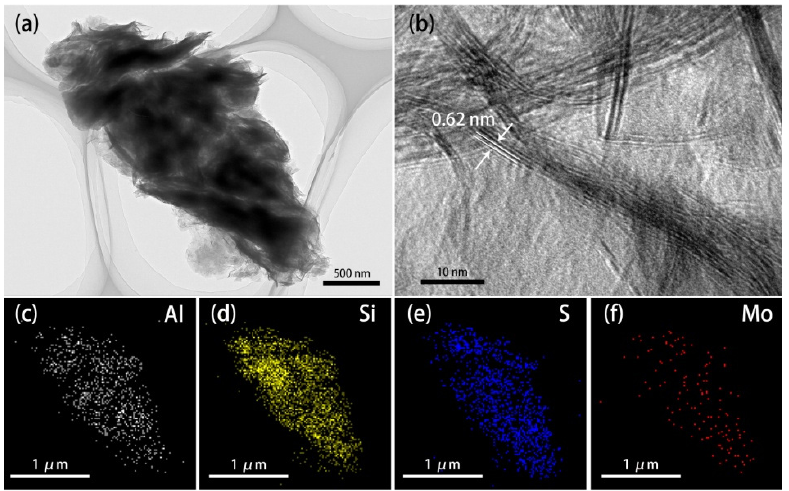
Figure 3. ( a ) TEM image and ( b ) HRTEM image of 1T-MoS 2 /PC, and ( c – f ) element distribution of Al, Si, S and Mo in 1T-MoS 2 /PC.